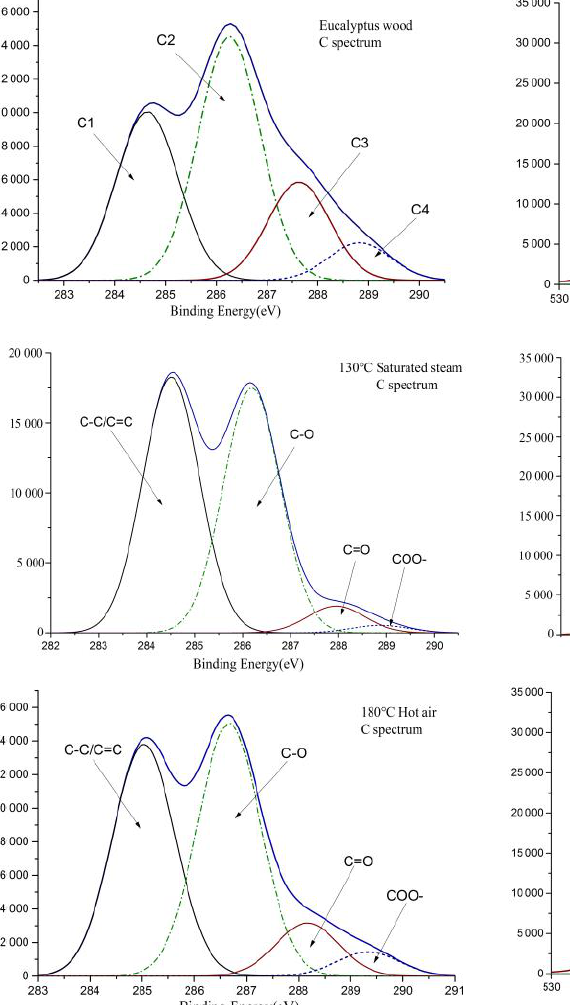
Figure 5. CPMAS- 13 C-NMR spectra of Eucalyptus and Burma padauk wood. The peak of the hemicelluloses acetyl group in the untreated Eucalyptus was the highest and gradually decreased with the decrease in treatment temperature, indicating that hemicelluloses were degraded during the heat treatment. The absorption of 105 ppm cellulose C1 was relatively stable, and it is generally used as a reference peak to compare the changes in other chemical components [40]. In this study, the semi-quantitative method was used to compare and analyze the differences in the content of the analyzed groups. The cellulose C1 peak was used as the integrated reference area, and the integral v alue in the range of ∫ (110– 95 ppm) was defined as the reference value = 1. The integrated area of the other peaks was divided by the reference value to obtain the content of this group relative to the cellulose C1 peak. Based on the values reported in previous studies [40 – 42], the chemical shifts, the relative integral values of peak areas, and attributions of NMR spectra are listed in Table 3. The content of the basic structural units of lignin changed obviously. The untreated Eucalyptus wood only contained an S structure in lig- nin. However, after heat treatment, the absorption peak of the G unit (149.25) appeared and strengthened, which reached 50% in content compared with Burma padauk. Mean- while, the S unit of the treated wood was reduced by 50% after heat treatment. This